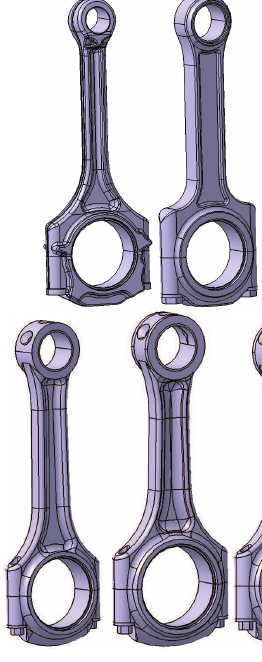
Fig. 21. All intermediate connecting rod